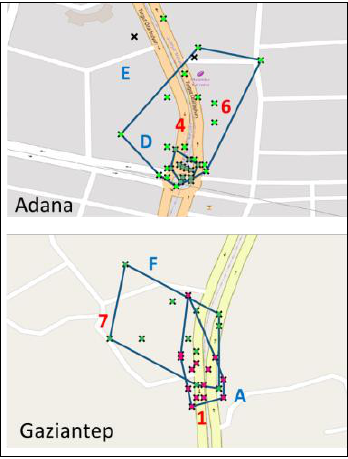
Figure 8. Mersin Region Repeatedly-detected Clusters in Different Periods (2014-2015, 2016-2017)